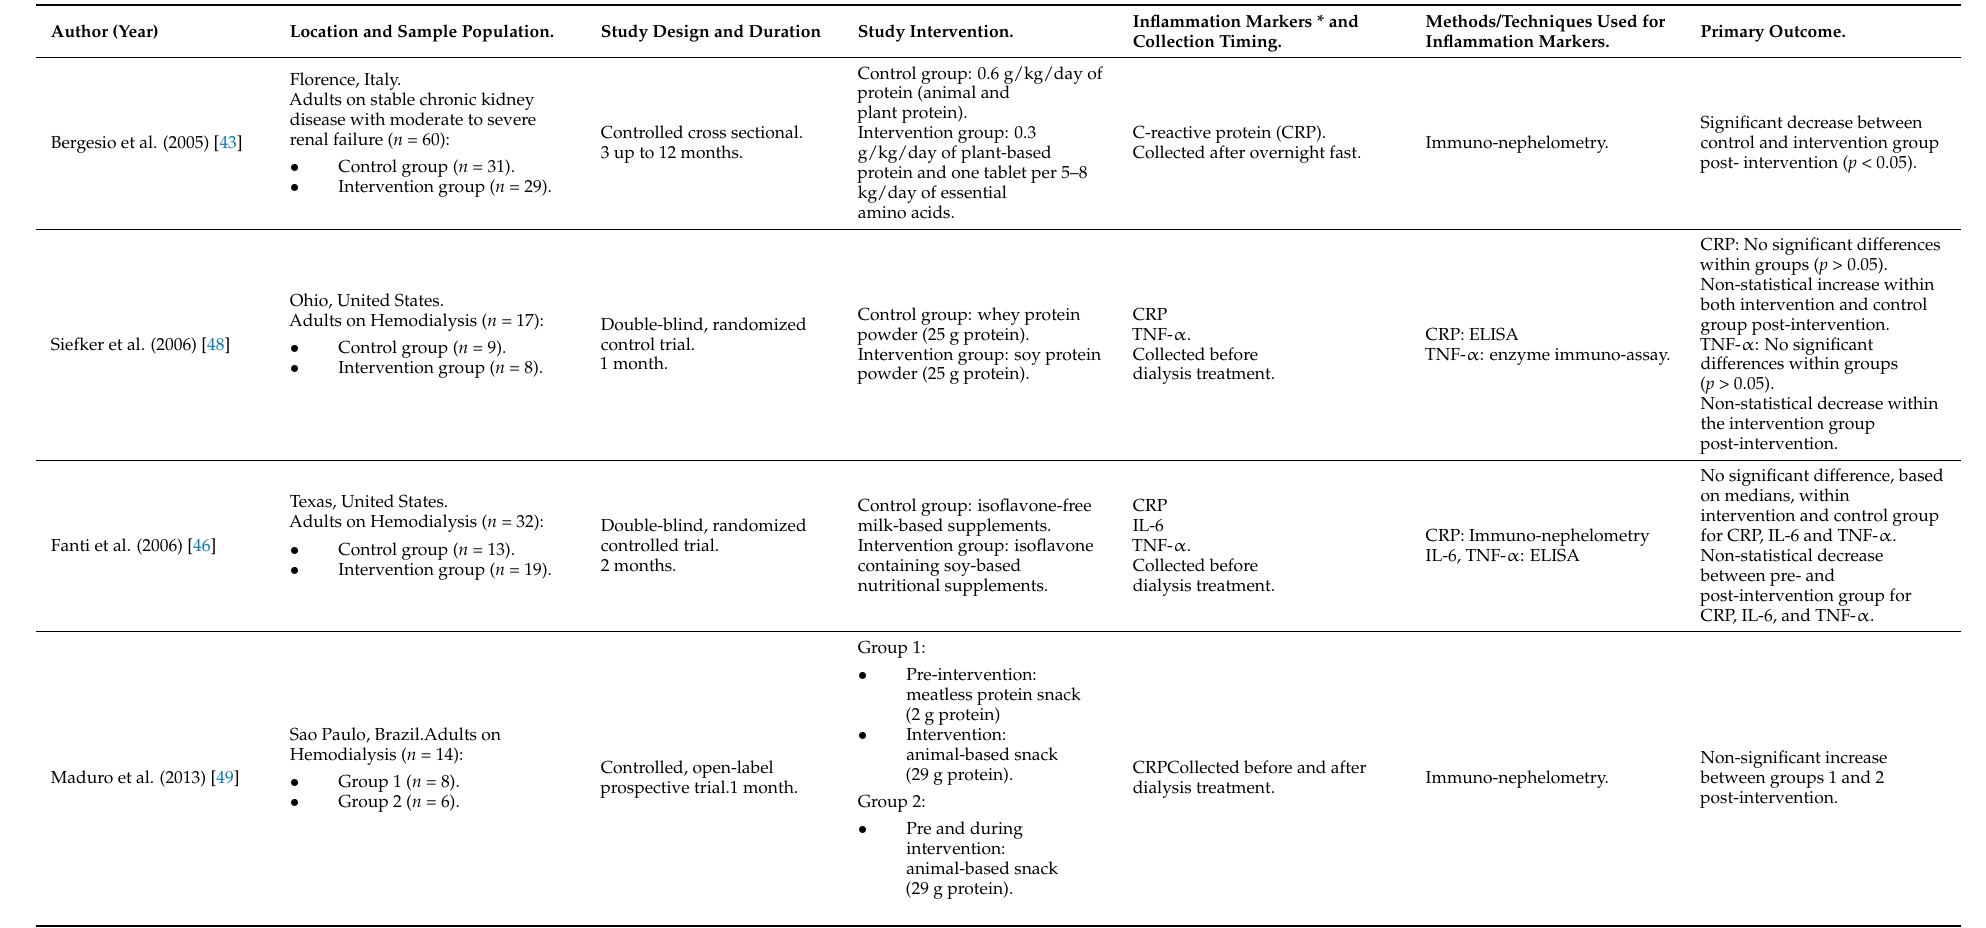
Table 1. Data extraction from the included studies ( n = 10) for the